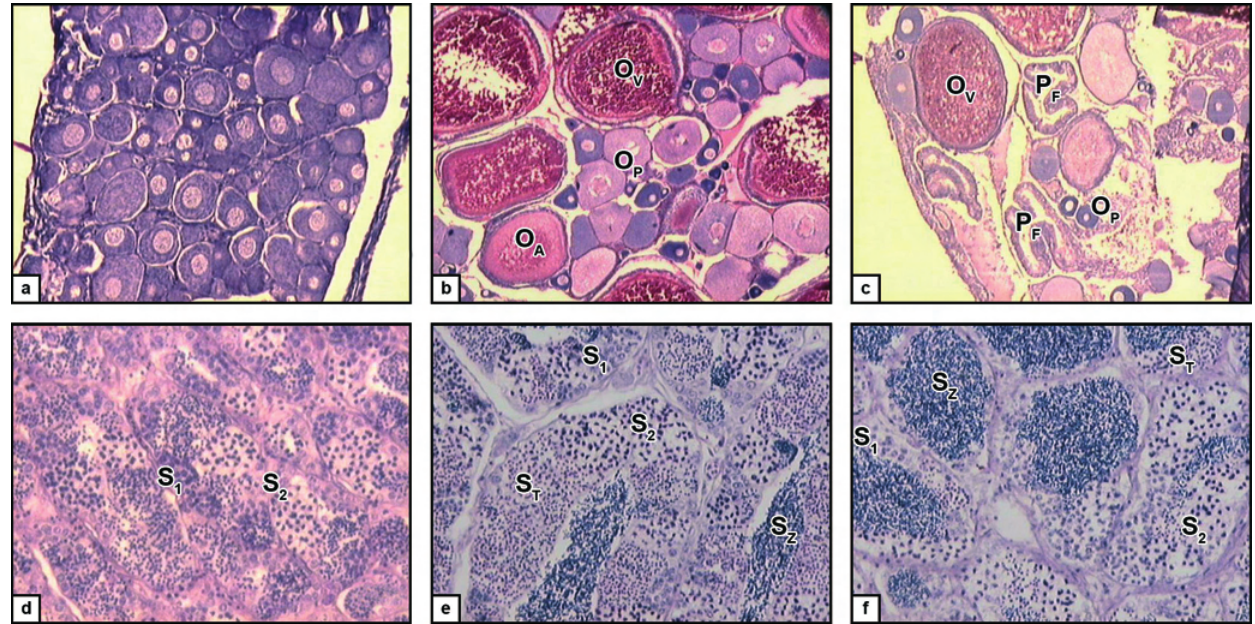
Fig. 7. Histological slides of gônads of Cichla kelberi female (a – c) and male (d – f) in Lobo reservoir (Bouin, hematoxylin and eosin). a- Resting ovary with perinucleolar oocytes (100x); b- In Maturation ovary showing group synchronous development of oocytes (40x); c- Spent ovary with post-ovulatory follicles (40x); d- Resting testicle (200x); e and f- In Maturation testicle : perinucleolar oocyte , O : cortical alveoli showing group synchronous development of spermatocytes (200x). Legend: O P A : vitellogenic oocyte , P : post-ovulatory follicle, S : primary spermatocyte , S : secondary spermatocyte, S : oocyte, O V F 1 2 T spermatid and S : spermatozoid. Z Table 1. Absolute fecundity estimated for females “in reproduction” of Cichla kelberi and oocyte counts of semi- spent females in Lobo Reservoir during the study period, compared to the GSI and total length. ( * Variables and param- eters estimated for semi-spent